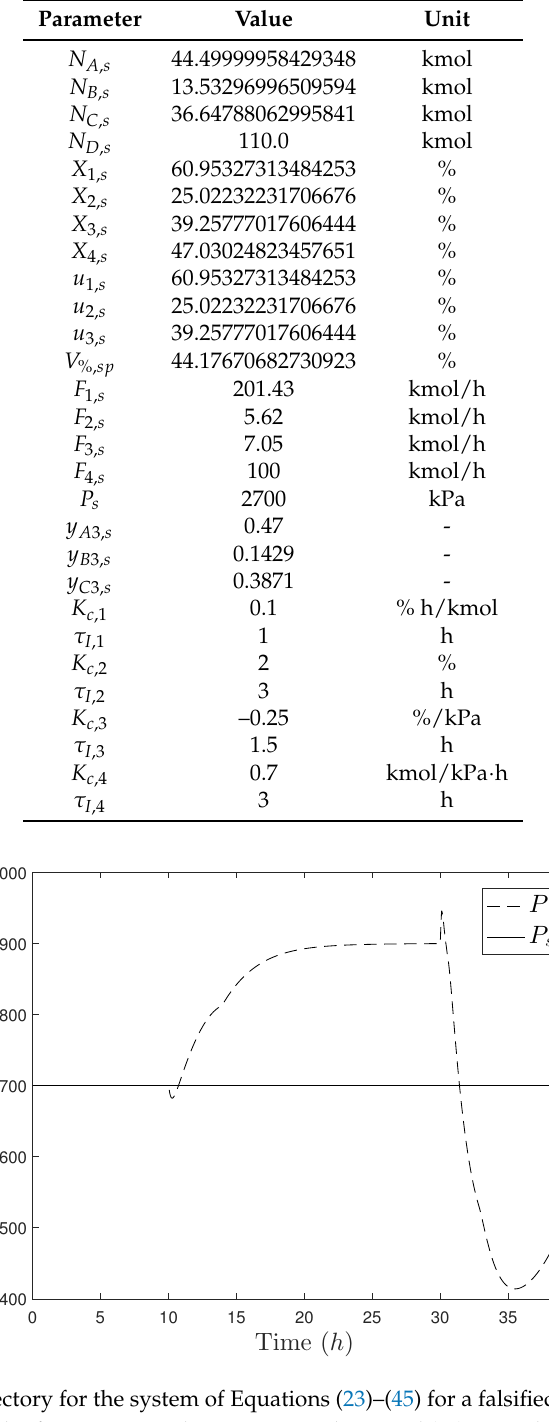
Table 1. Steady-state values for the states of the Tennessee Eastman Process [78].